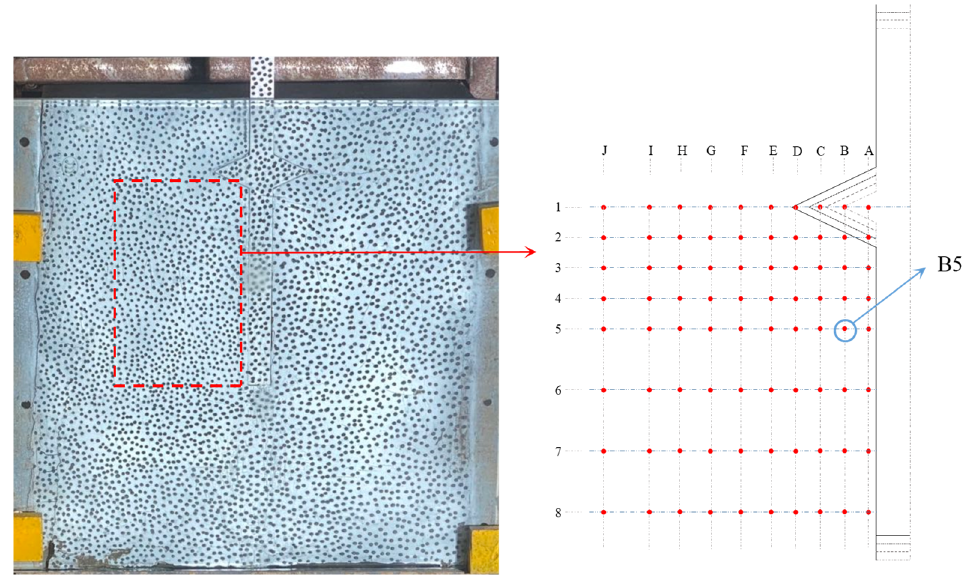
Figure 6. Distribution of data points.